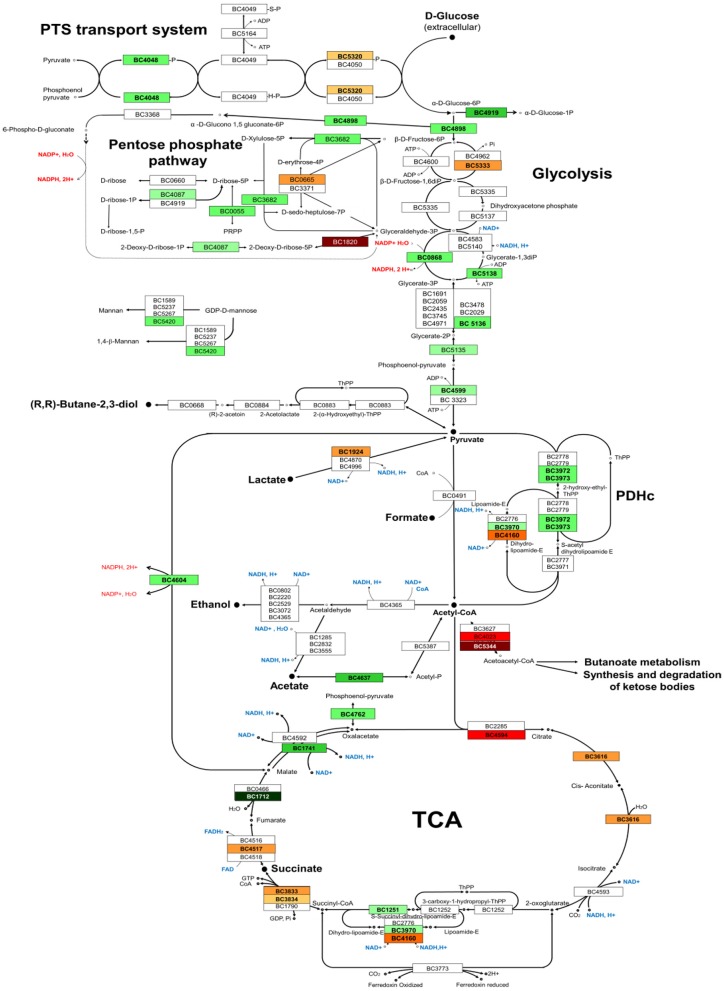
Overview of the glucose catabolic pathways utilized by B. cereus ATCC 14579. The proteins detected in this study are indicated by their BC numbers. Protein names and functions are listed in Table S3. The form filling indicates fold-change values that satisfied the Student's t-test statistical criteria (p < 0.05). Red and green BC numbers indicated significant increase and decrease, respectively, of abundance level of the proteins in the ΔentD mutant compared with wild-type.